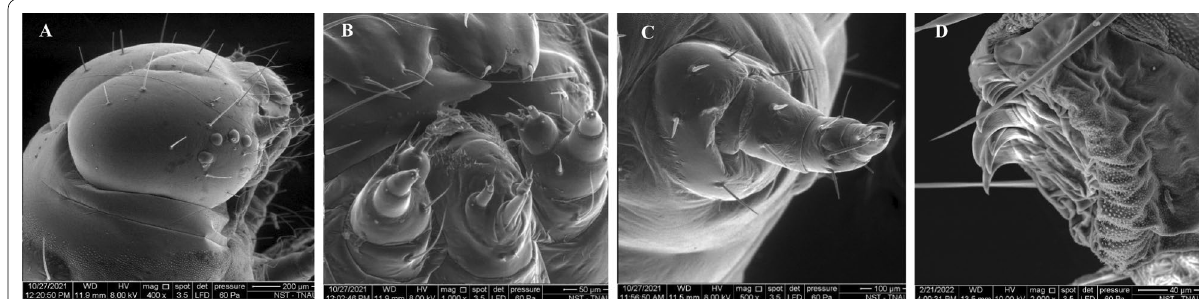
Fig. 2 SEM images of healthy second instar of Spodoptera frugiperda . a . Dorsal view of head region. b . Ventral view of head region showing mouthparts. c . Thoracic leg with seta. d . Full view of abdominal prolegs with crochets (arrowheads)